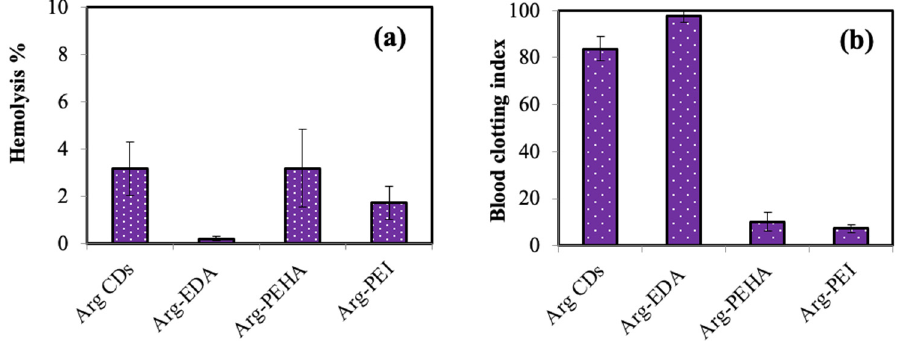
Figure 4. ( a ) Hemolysis % and ( b ) blood clotting indexes of Arg CDs and their modified forms at 250 μ g/mL concentration.